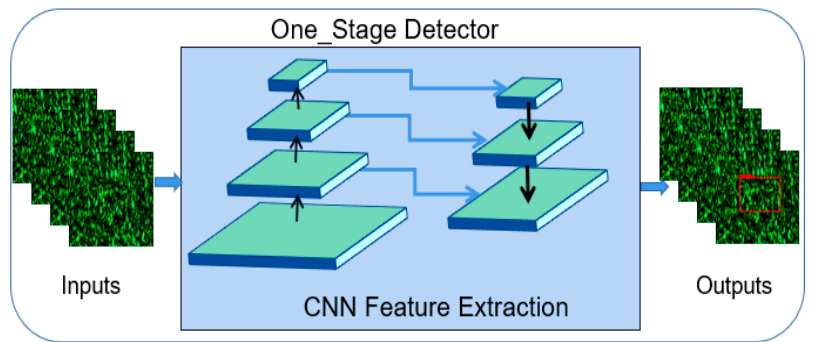
Figure 3. Single-stage target-position detection; that is, a single network can perform the target location estimation task. The red box represents the target location results output by the model.